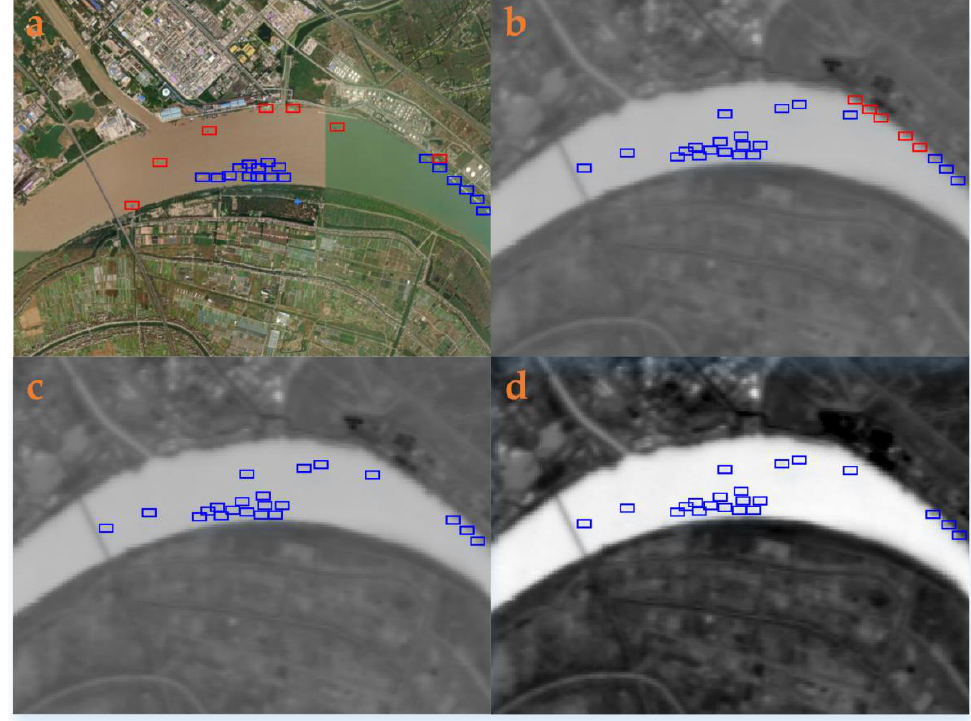
Figure 2. Jiajiang River local RSIs: ( a ) Google Maps images. TIRSIs: ( b ) annotations all types of vessels, ( c ) annotations of select vessels (intra-class variations considered), ( d ) data of images after contrast stretching (in TIRSIs: a blue box is a complete ship, a red box is a partial ship).